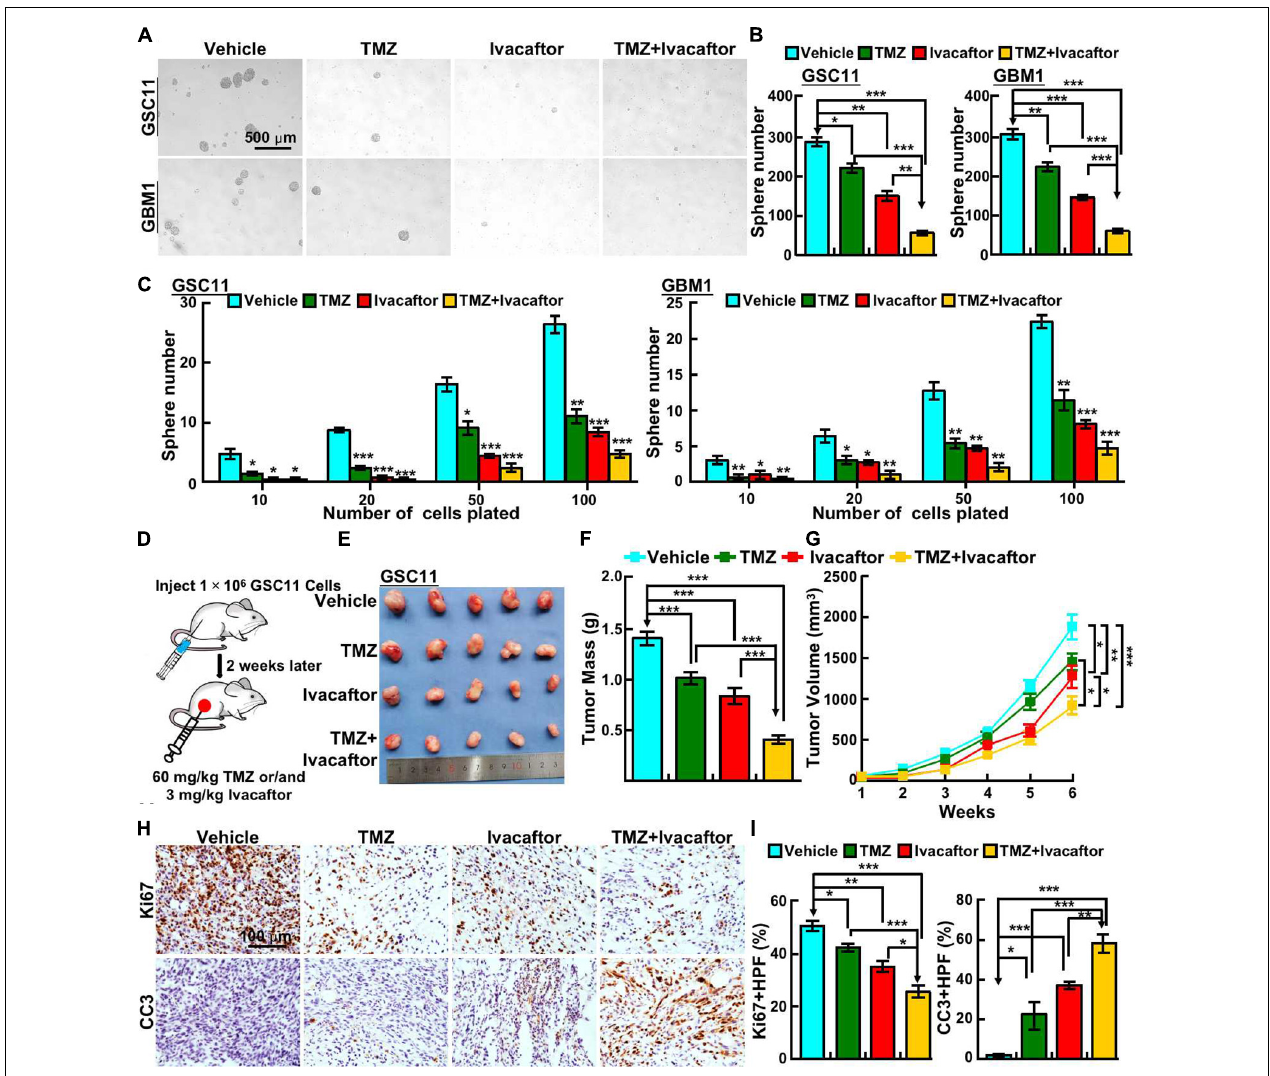
FIGURE 3 | Ivacaftor sensitizes GSCs response to TMZ. (A,B) Ivacaftor plus TMZ decreased GSC11 (top panel) and GBM1 (bottom panel) cells tumor sphere formation ability. Scale bar: 500 µ m. (B) Quantification result of (A) . (C) Tumor sphere derived from GSC11 (left panel) and GBM1 (right panel) cells were counted after treating indicated cells with 200 µ M TMZ, 5 µ M ivacaftor, or 5 µ M ivacaftor combined with 200 µ M TMZ. (D) Flow chart of xenograft tumor formation assay in nude mouse. (E) Representative images of tumors treated with 3 mg/kg ivacaftor alone or combined with 60 mg/kg TMZ. (F) Tumor masses of xenograft tumors treated with indicated drugs were shown. (G) Tumor volumes of xenograft tumors treated with indicated drugs were shown. (H,I) Representative images of immunohistochemical staining of Ki67 and CC3 in xenograft tumor sections. CC3 means cleaved caspase 3. (I) Quantification data for panel (H) . Data are shown as means ± SEM, * P < 0.05; ** P < 0.01; *** P < 0.001; t